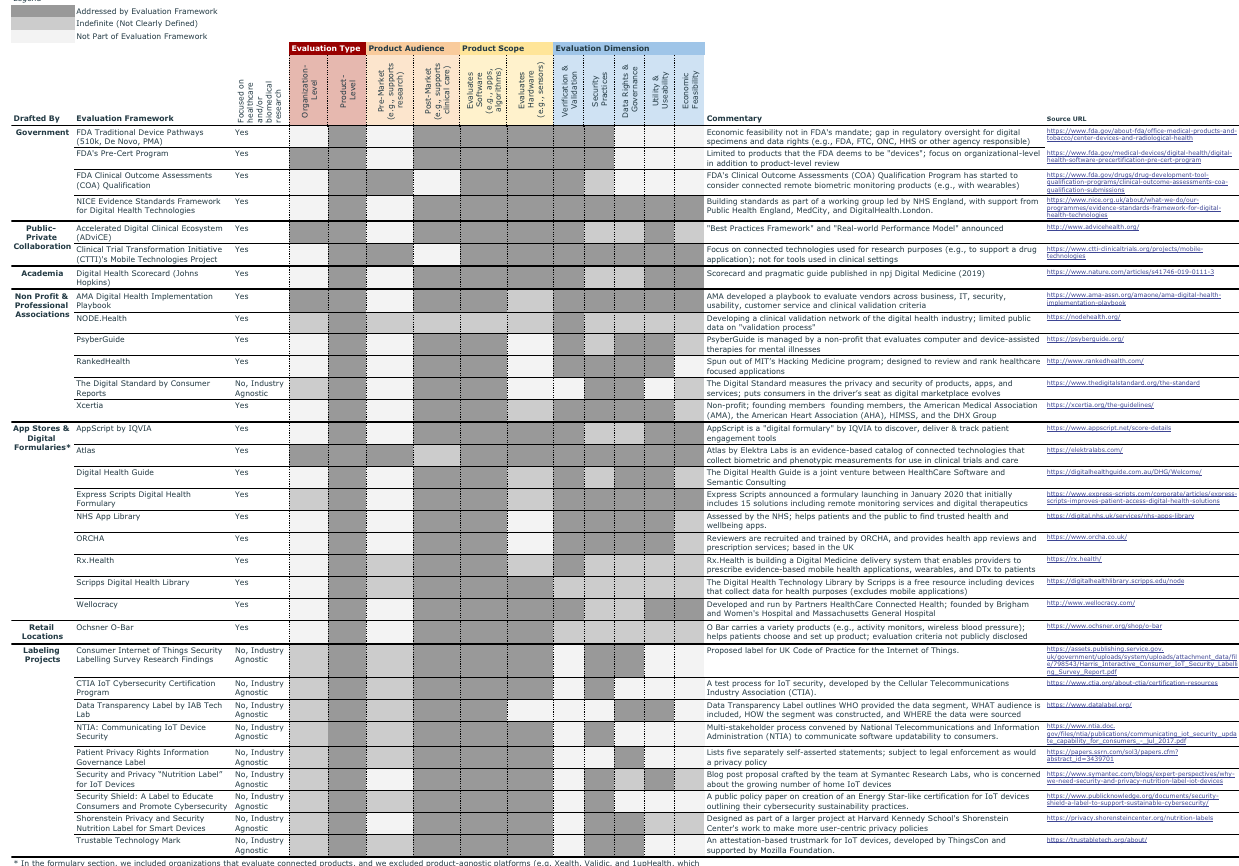
Fig. 1 Current Evaluation Frameworks for Connected Sensor Technologies. This fi gure illustrates many of the known evaluation frameworks for connected technologies, categorized by source, type, audience, scope and dimension. References are